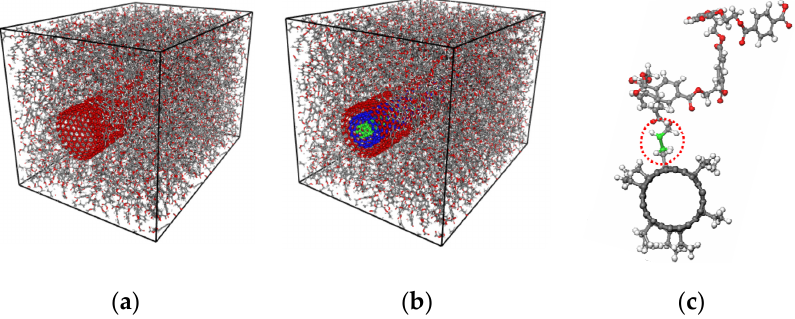
Figure 2. Molecular models of ( a ) grafted SWNT/PET nanocomposites, ( b ) grafted MWNT/PET nanocomposites, and ( c ) covalent grafting between the carbon nanotubes (CNT) and PET chain. Table 1. Unit-cell composition of nanocomposites.